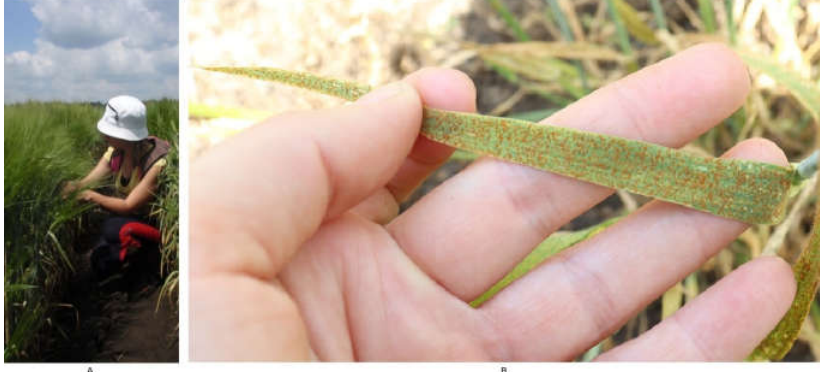
Figure 2. Accounting for the development of barley leaf rust in the field: ( A ) accounting for the development of the disease (orig.); ( B ) a barley leaf infected with a leaf rust pathogen (orig.).